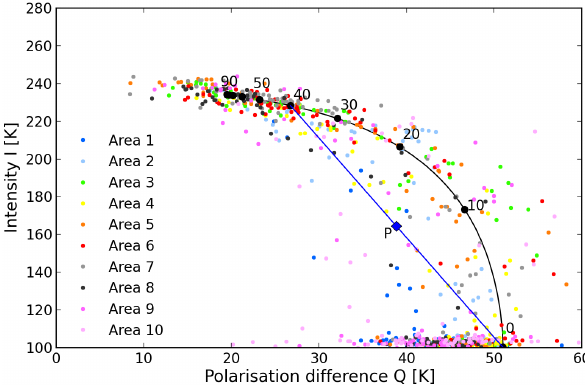
Fig. 6. Retrieval curve of SIT from I and Q . Dot colours belong to different regions (see Fig. 3). Numbers at the curve mark the retrieved SIT in centimetre. Observation point P can be synthesised by observing thicknesses of 0 and 40cm (blue line) in one footprint. Table 1. Parameters for fit function in Eqs. (3) and (4).